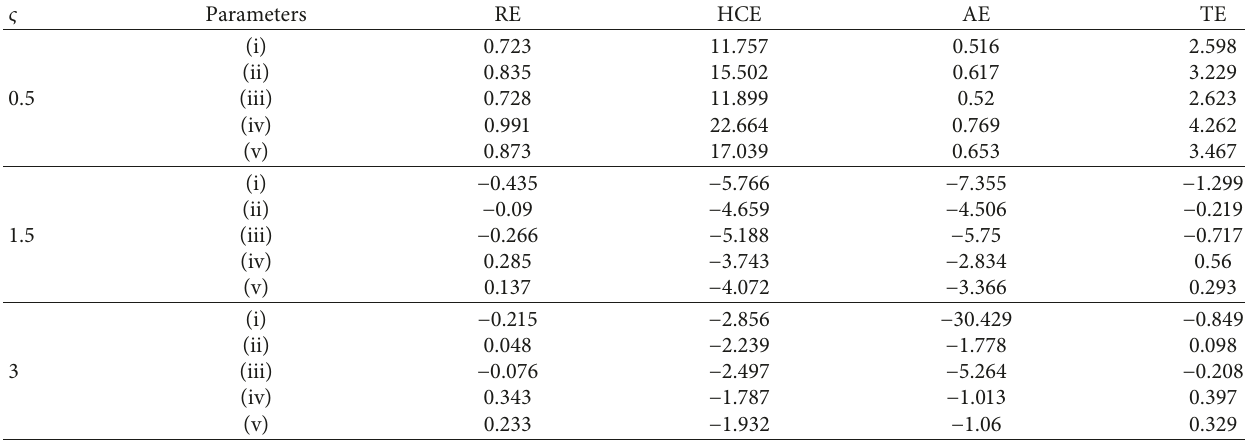
Table 3: Numerical values of entropy measures of IELoP